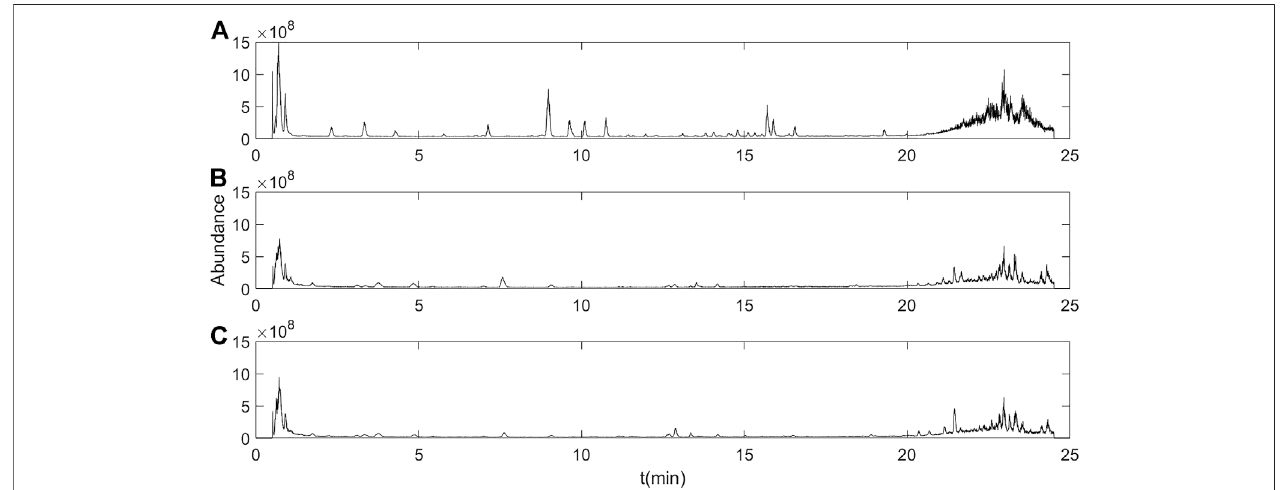
FIGURE 7 | Total ion chromatogram of XKST (A) , blank plasma (B) , and plasma-containing drug (C) .